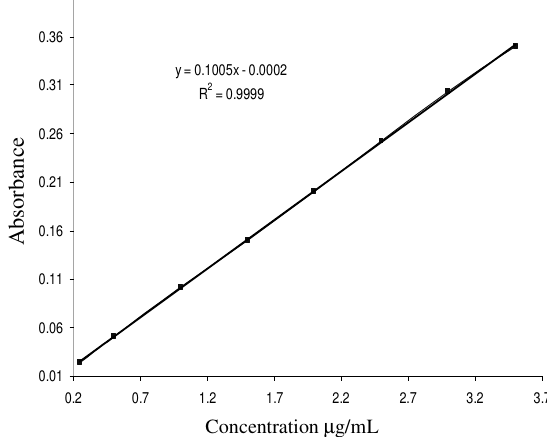
Figure 3. Linearity of absorbance corresponding the concentration of the proposed method. Table 1. Summary of optical and regression characteristics of the proposed